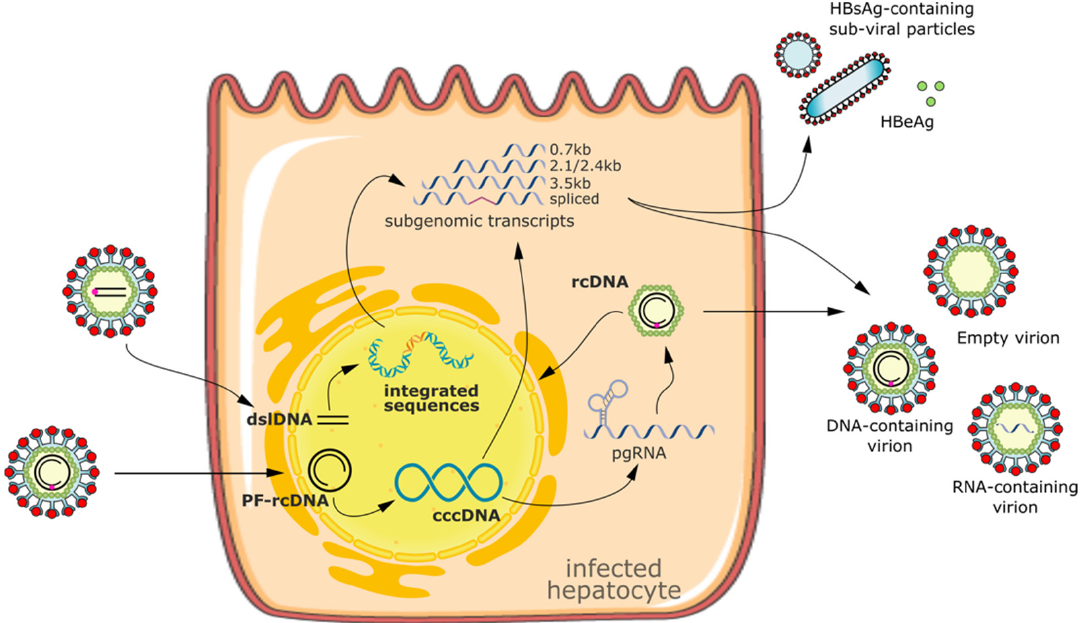
Figure 1. Schematic representation of HBV lifecycle and HBV genomic forms potentially targeted by gene editing. Once it has entered into the hepatocytes, the rcDNA and the dslDNA are released into the nucleoplasm, where PF-rcDNA is converted into cccDNA, while dslDNA might represent the substrate for HBV integration into the host genome. cccDNA is the only template for viral pregenomic RNA (pgRNA) and all the viral subgenomic mRNAs, while HBsAg and a truncated but potentially functional HBx form can be produced from integrated HBV DNA. pgRNA is retrotranscribed by the viral polymerase into rcDNA. A fraction of rcDNA is packaged and released, forming new infectious particles (i.e., Dane particles), while some will be transported to the nuclei to replenish the cccDNA pool. rcDNA, dslDNA, cccDNA and HBV integrated sequences have been demonstrated to be targeted by gene editing. It remains to be elucidated whether the rcDNA contained in the neo-formed cytoplasmic nucleocapsids could also be modified. rcDNA, relaxed circular DNA; PF-rcDNA, protein-free relaxed circular DNA; dslDNA, double-strand linear DNA; cccDNA, covalently closed circular DNA.